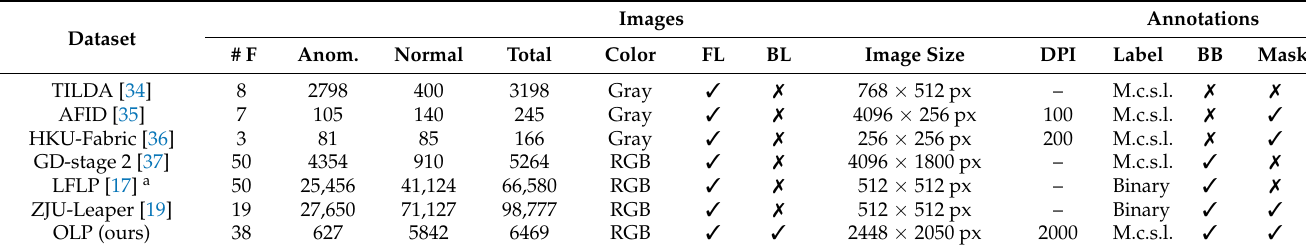
Table 1. Comparison of publicly available fabric defect datasets and the dataset OLP generated in this study. We use – to denote when the information about a characteristic is not available for a given dataset. Note that ZJU-Leaper [19] and LFLP [17] are concurrent works that were not yet publicly available at the time the research presented in this paper was conducted. Furthermore, (cid:51) denotes the presence of an attribute, and (cid:55) denotes its absence. Abbreviations: FL = Front-light; BL = Back-light; M.c.s.l. = Multi-class single-label; # F = Number of fabrics; BB = Bounding box; Anom =